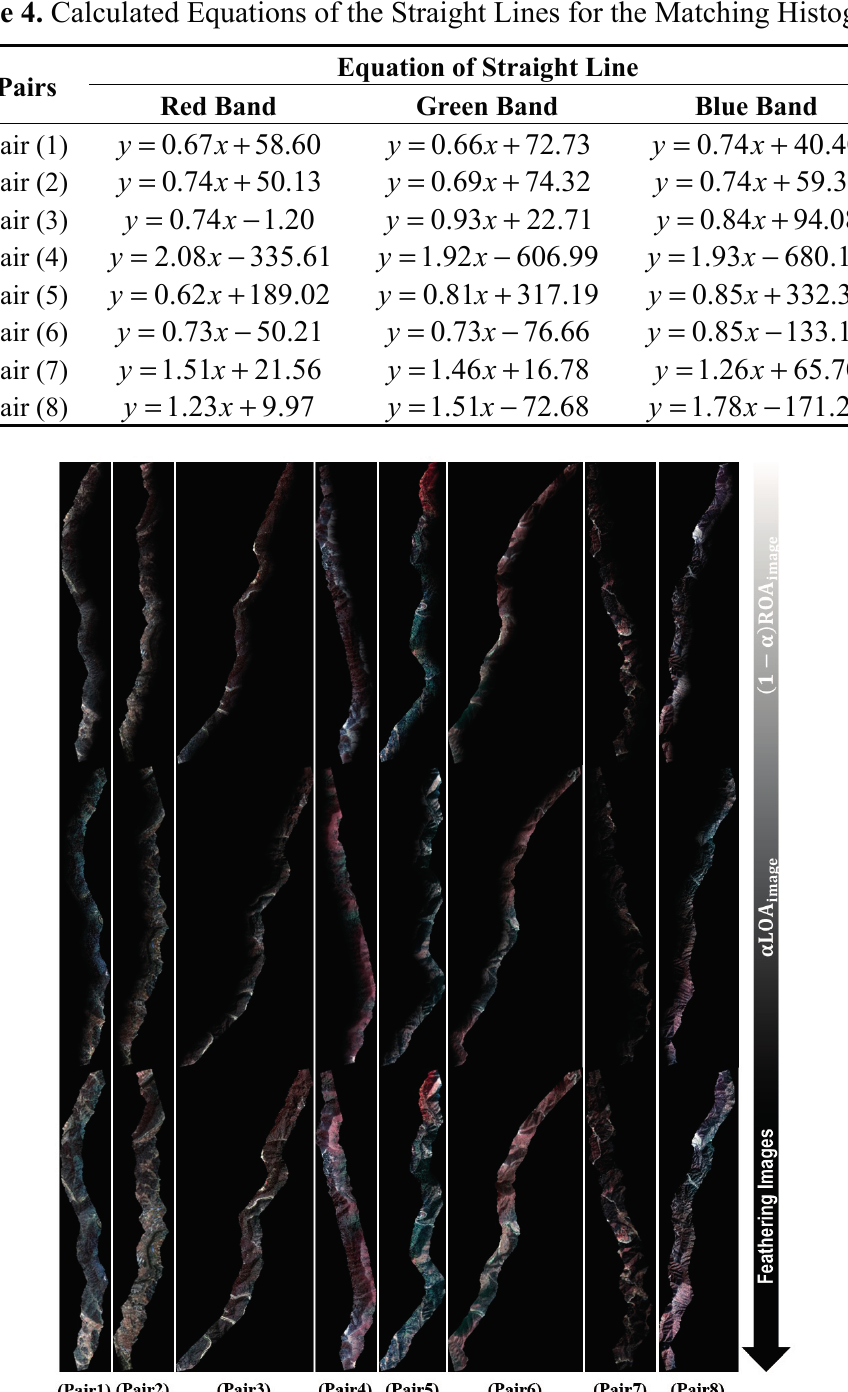
Figure 7. The products of each step and the results of feathering the